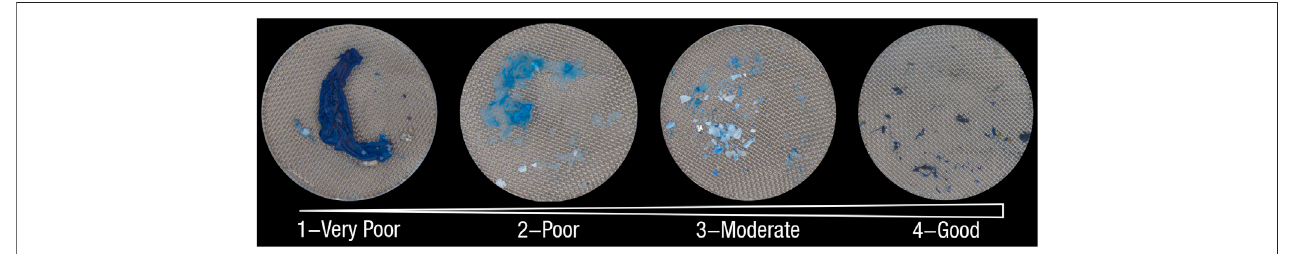
FIGURE 3 | Illustration of overall digestion level scores.